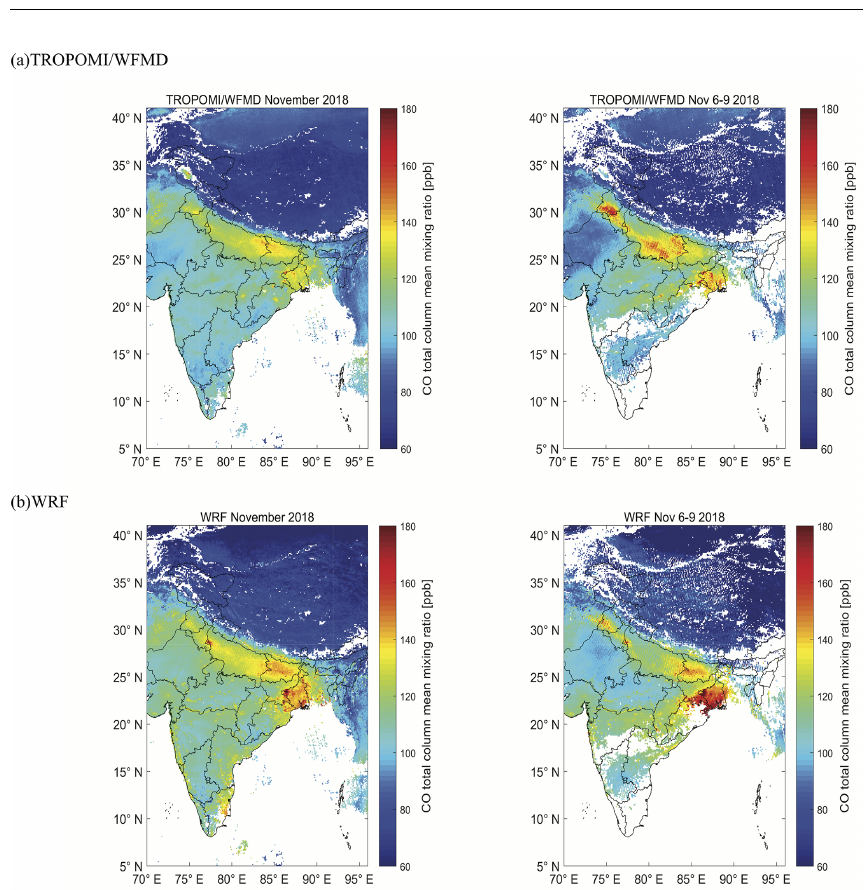
Figure 3. CO total column mixing ratios averaged for (a) TROPOMI/WFMD and (b) WRF over all of November 2018 (left panel) and from 6–9 November 2018 (right